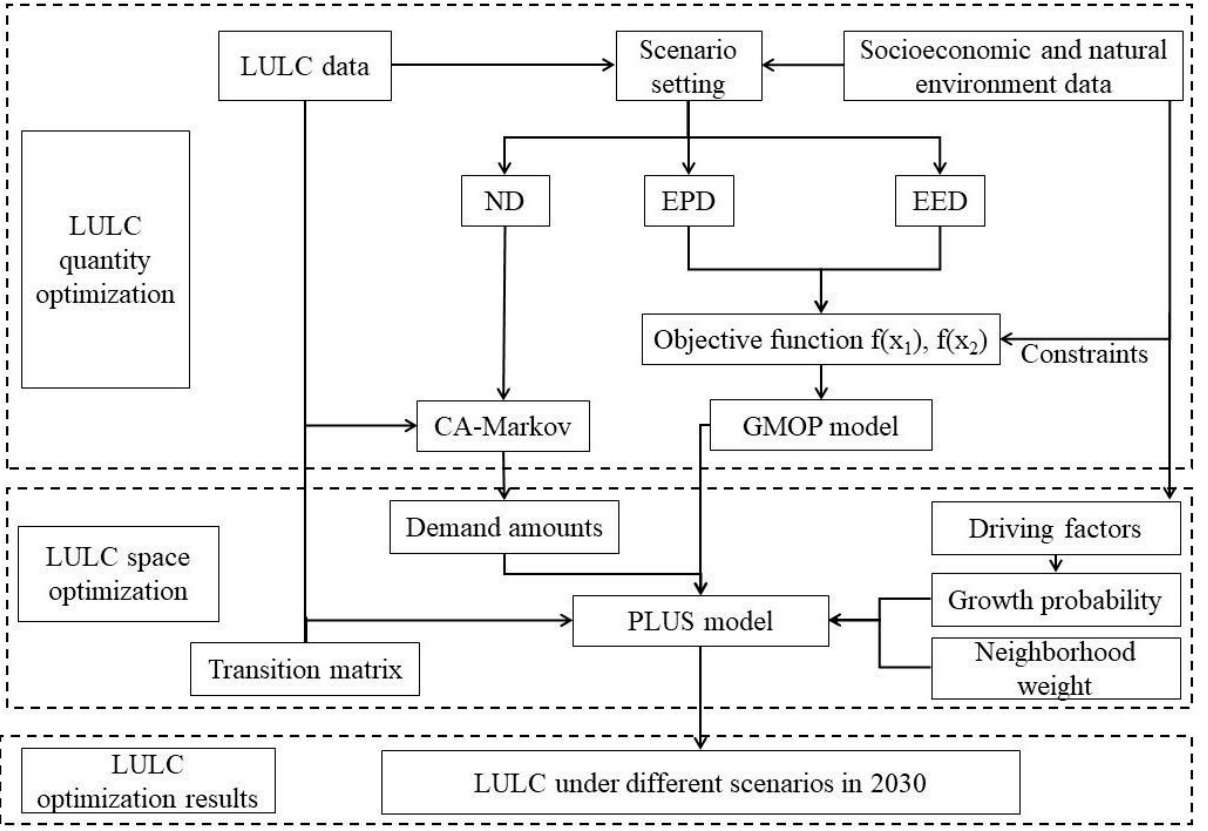
Figure 3. Coupling flow chart of GMOP–PLUS model.